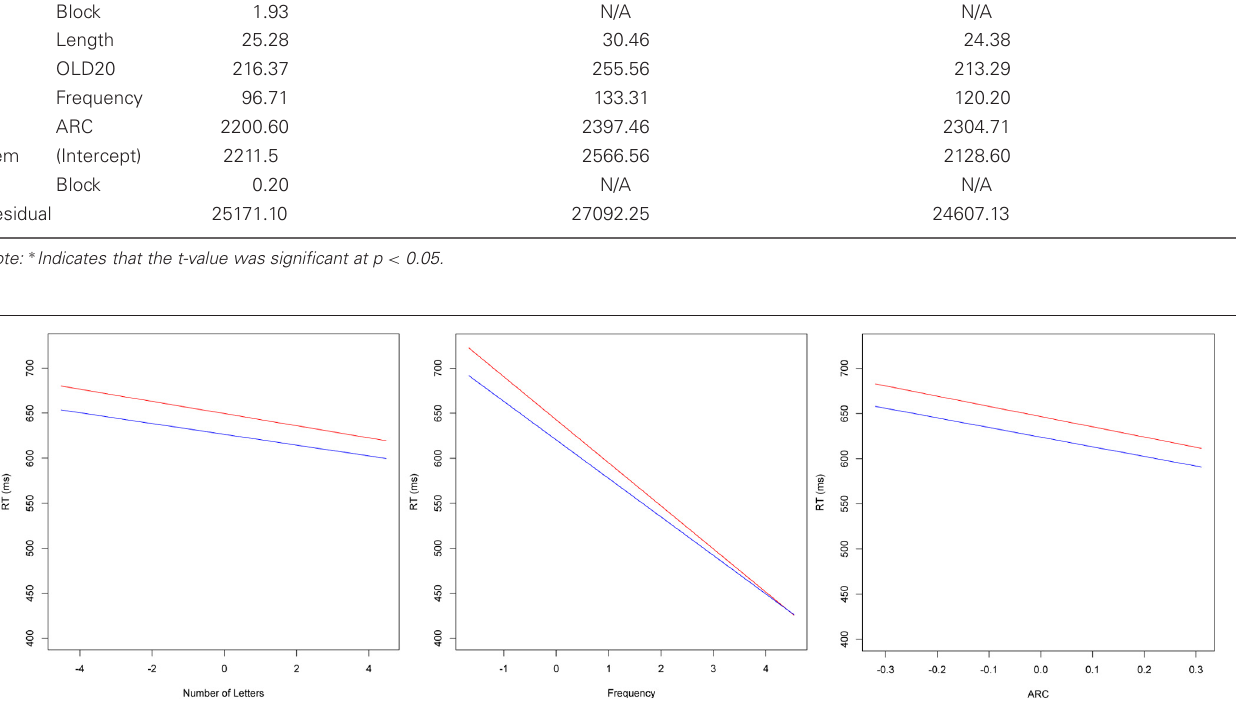
FIGURE 1 | Plots of fixed effects from a model fitted to LDT reaction times to 25,463 words for early (less than block 28; red) and late (greater than block 28 but excluding the shortened block 57; blue)